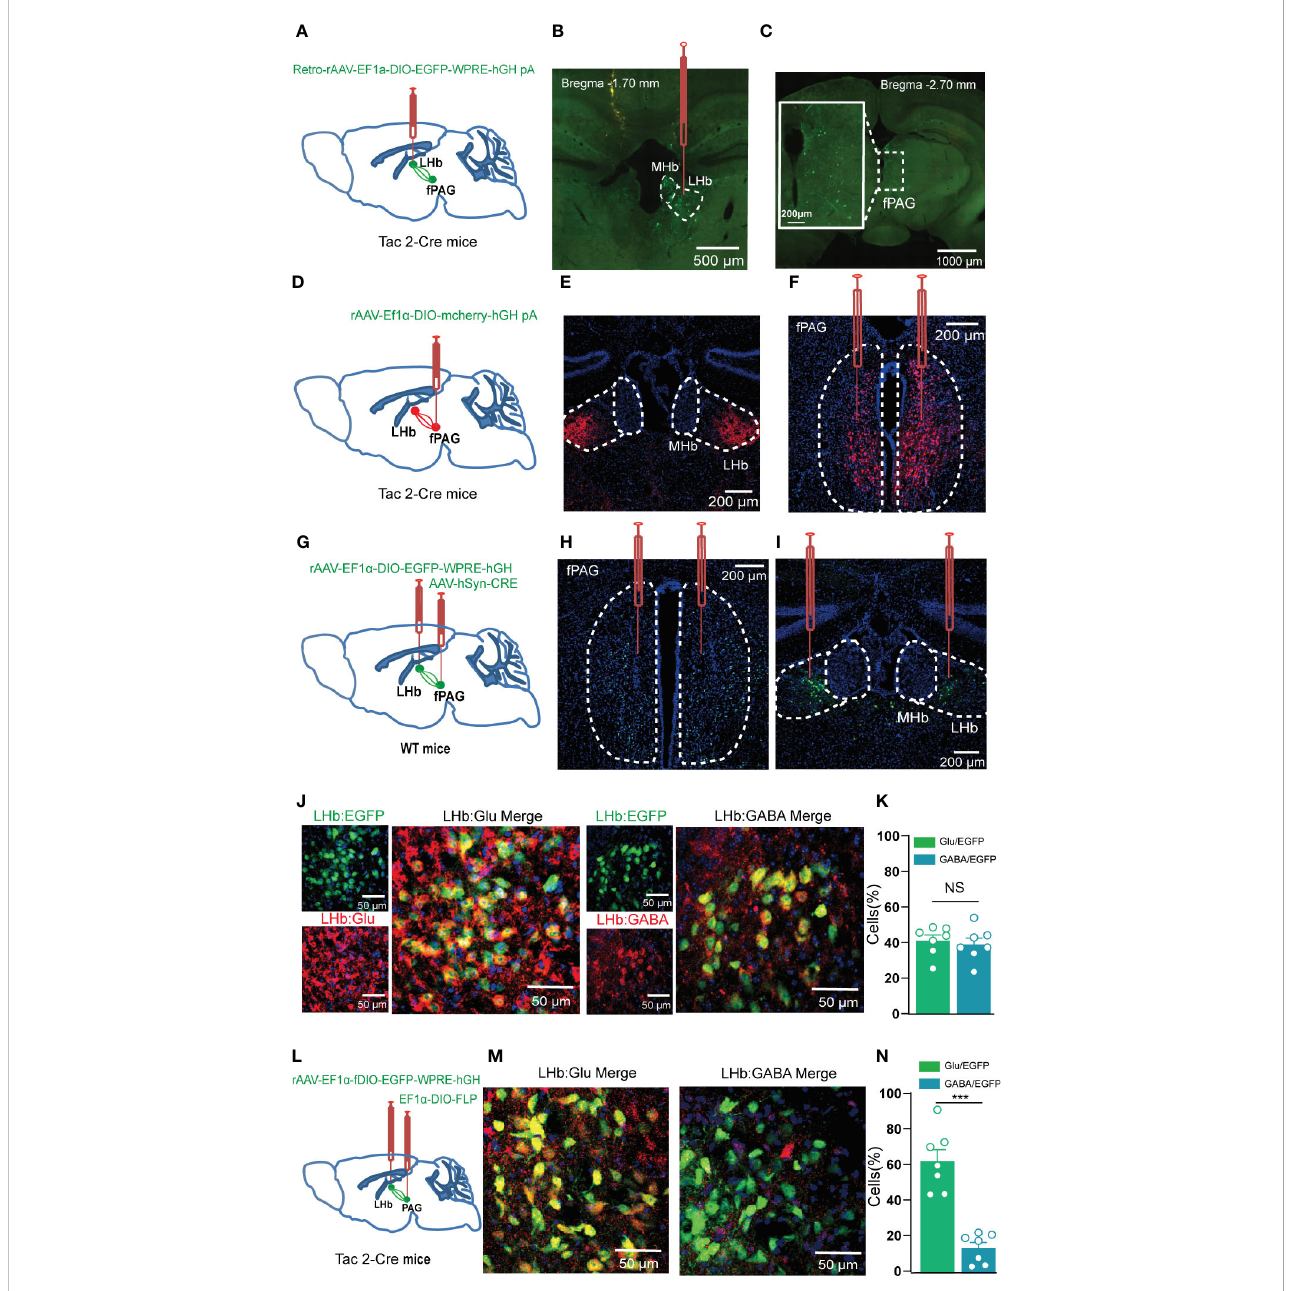
FIGURE 7 The fPAG projects NKB-positive nerve fi bers to the LHb. (A, B) Schematic (A) and representative image (B) of injection of Retro-rAAV-EF1a-DIO – EGFP into the LHb of Tac2-Cre mice. (C) Representative image of fPAG EGFP + neurons. (D) Schematic of injection of anterograde rAAV-EF1a-DIO – mCherry- hGH into the fPAG of Tac2-Cre mice. (E) Representative image of an mCherry+ terminals in the LHb. (F) Typical image of fPAG neurons. (G) Schematic of the Cre-dependent anterograde trans-monosynaptic tracing strategy in WT mice. (H, I) Typical images showing the neurons in the fPAG (H) and the LHb (I) . (J) Images showing that GFP-labeled neurons within the LHb co-localized with glutamate and GABA immuno fl uorescence. (K) Data showing that GFP-labeled neurons within the LHb co-localized with glutamate and GABA immuno fl uorescence. (L) Schematic of the Cre-dependent anterograde trans-monosynaptic tracing strategy in Tac2-Cre mice. (M) Images showing that GFP-labeled neurons within the LHb of Tac2-Cre mice co-localized with glutamate and GABA immuno fl uorescence. (N) Data showing that GFP-labeled neurons within the LHb mainly co-localized with glutamate immuno fl uorescence in Tac2-Cre mice.